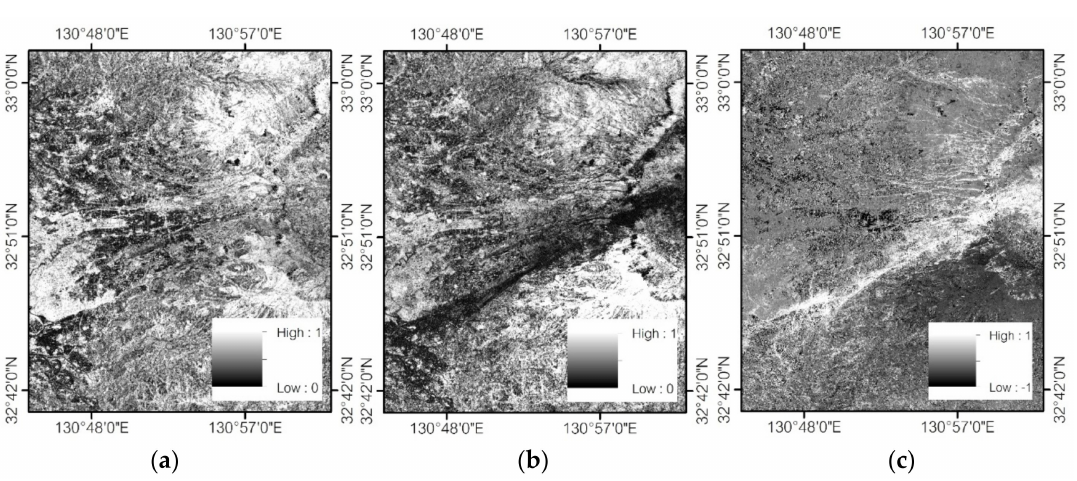
Figure 2. ( a ) Pre-earthquake coherence, ( b ) during-earthquake coherence, and ( c ) coherence change index